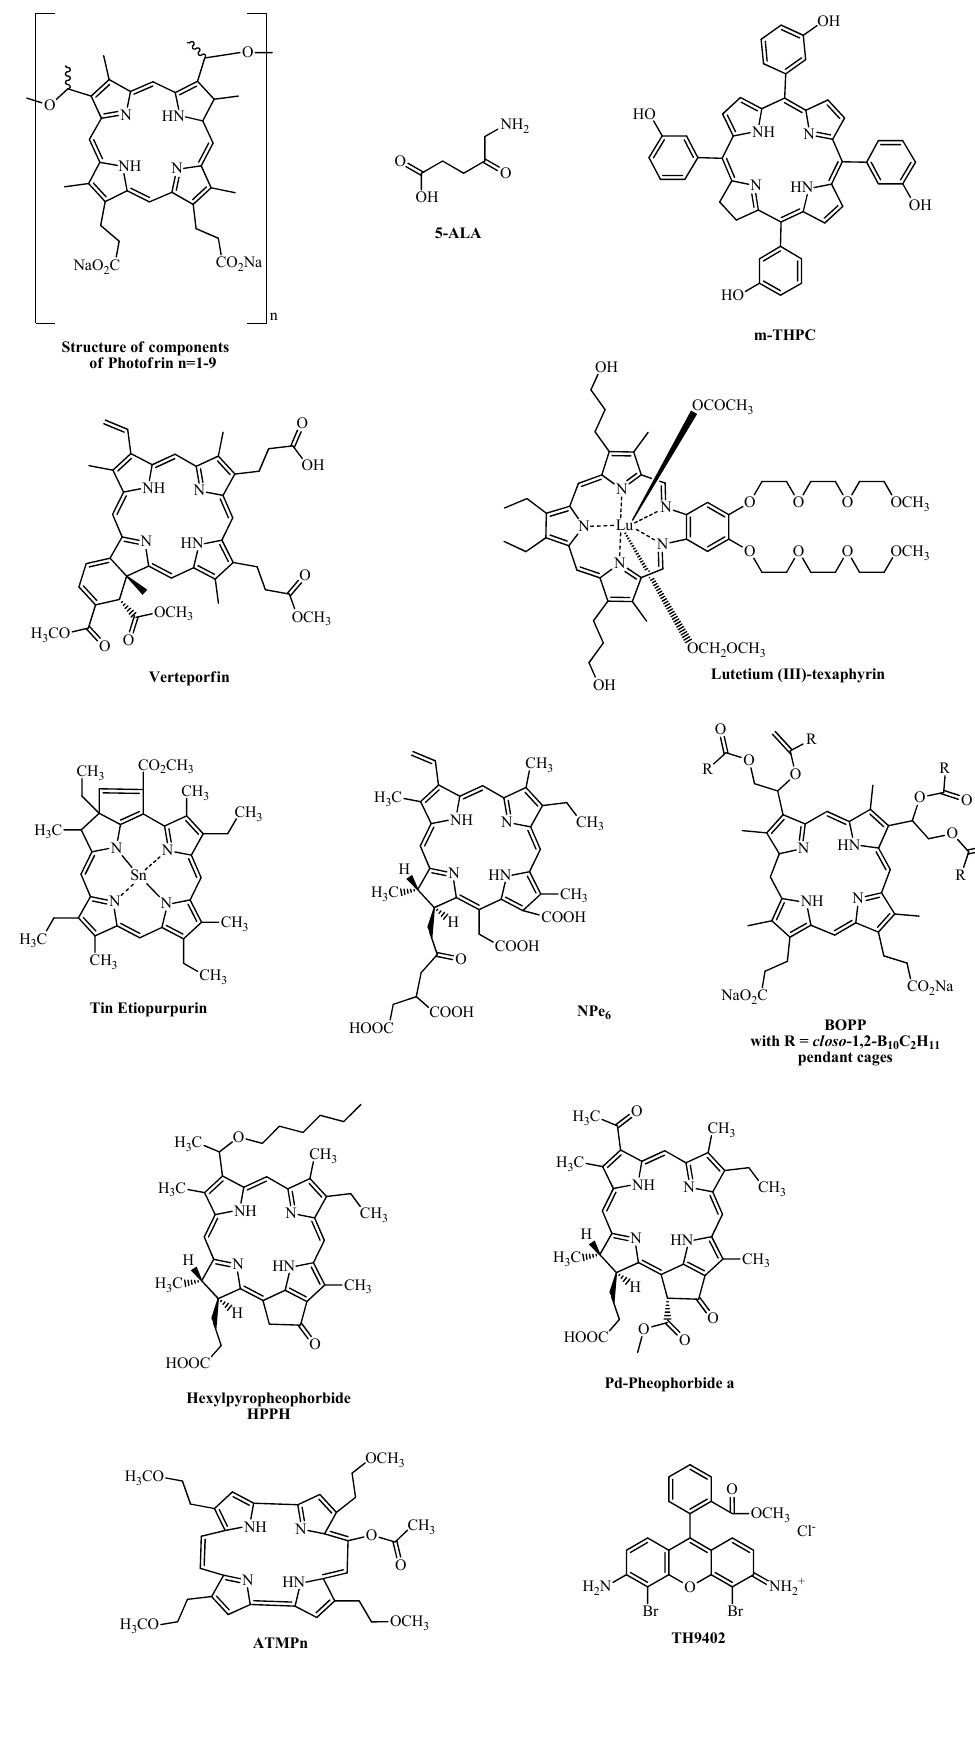
Figure 1. Chemical structures of clinically relevant “non-phthalocyanine”